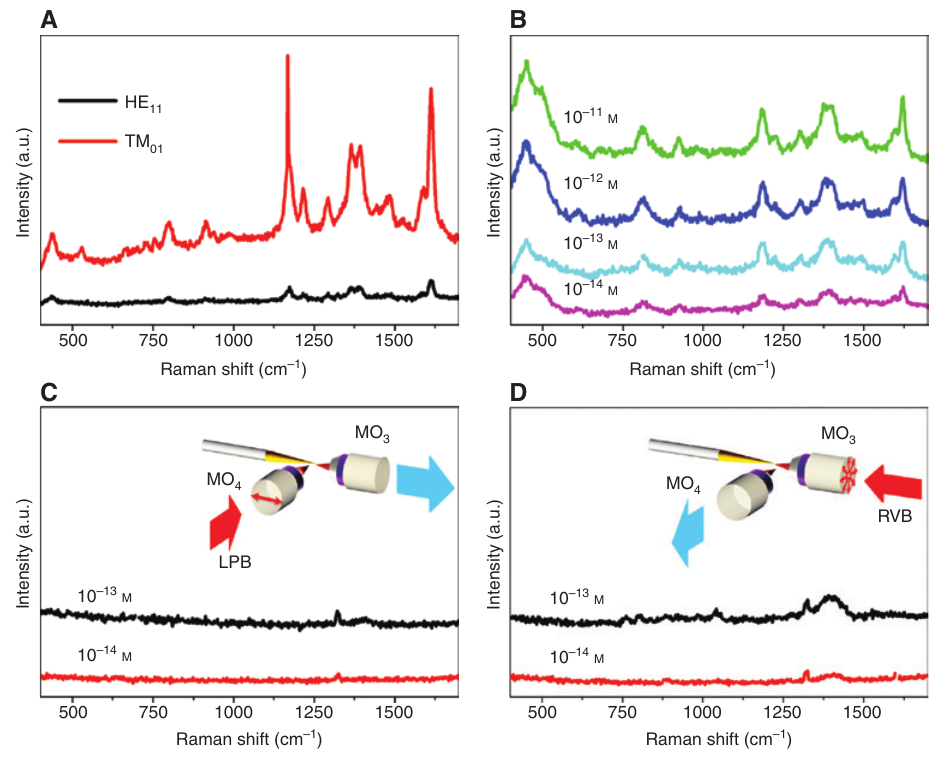
Figure 5: Plasmonic nanofocusing using Ag-coated fiber tip with internal illumination of RVM. (A) Raman spectra of MG (10 −2 m) absorbed on the surface of the Ag-coated fiber tip and internally excited with OM (red curve). (B) Raman spectra of MG (10 −11 , 10 −12 , 10 −13 , and 10 −14 m) internally excited with OM laterally excited with LPB. (D) Raman spectra of MG (10 −13 and 10 −14 m) vertically excited with